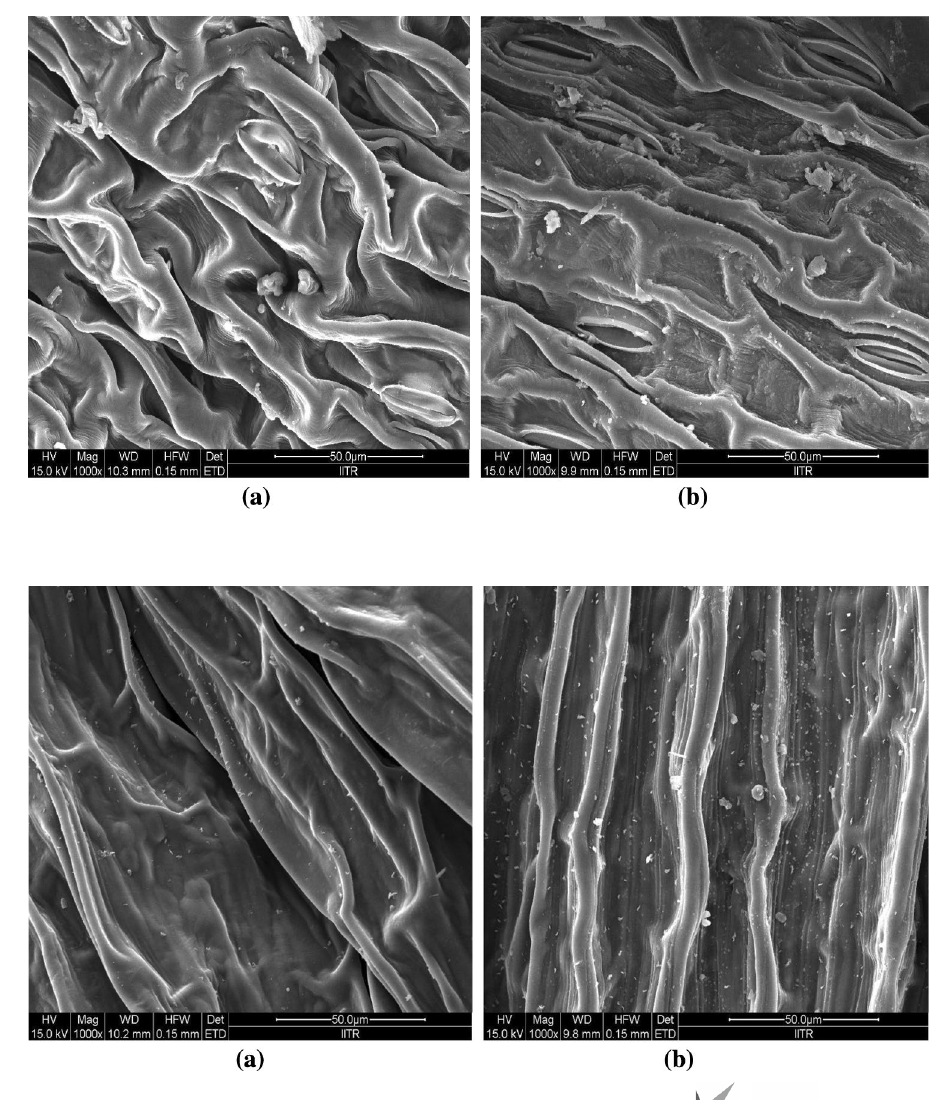
Fig. 2 a SEM analysis of Eichhornia crassipes leaves unloaded with phenol and cya- nide and b loaded with phenol and cyanide (at a magnification of 1 K)